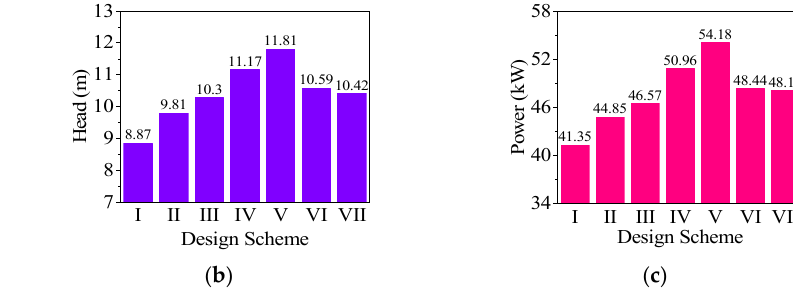
Figure 10. Energy performance under design flow rate conditions: ( a ) efficiency; ( b ) head; and ( c ) power.